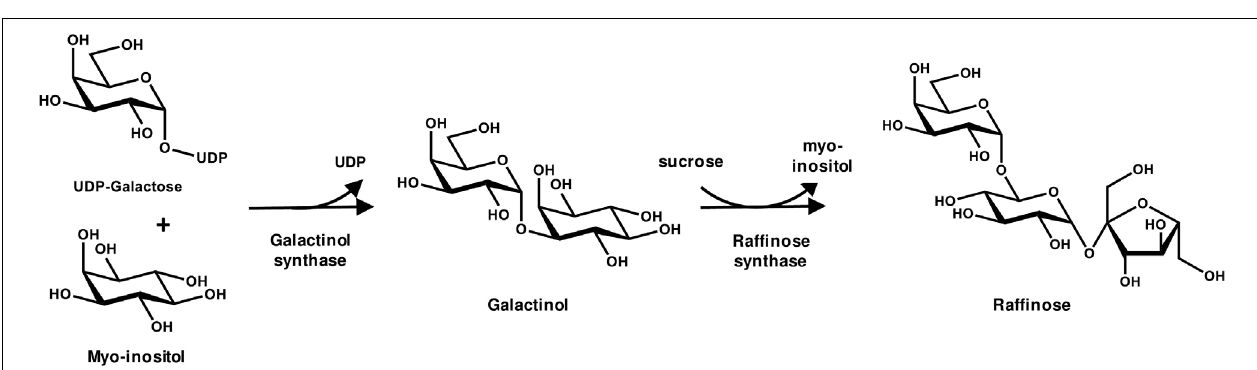
FIGURE 4 | The biochemical pathway of Raffinose Oligosaccharide